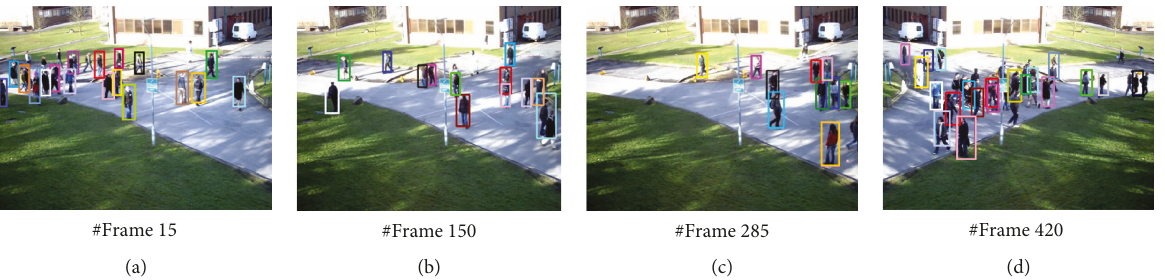
Figure 7: Qualitative tracking results of our tracker on PETS09-S2L2.